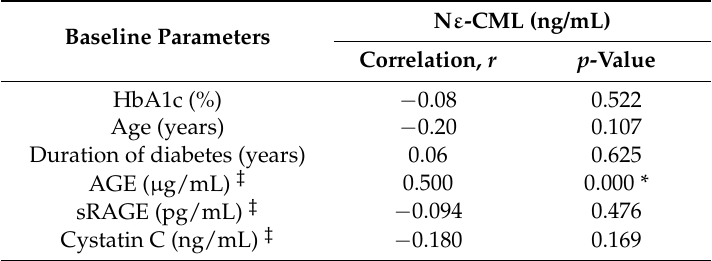
Table 5. Correlation between baseline parameters and N ε